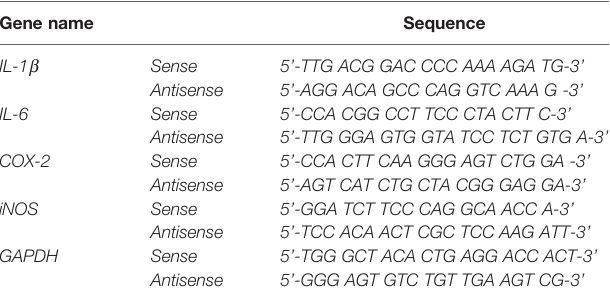
TABLE 2 | Sequences of primers used for real time-PCR.